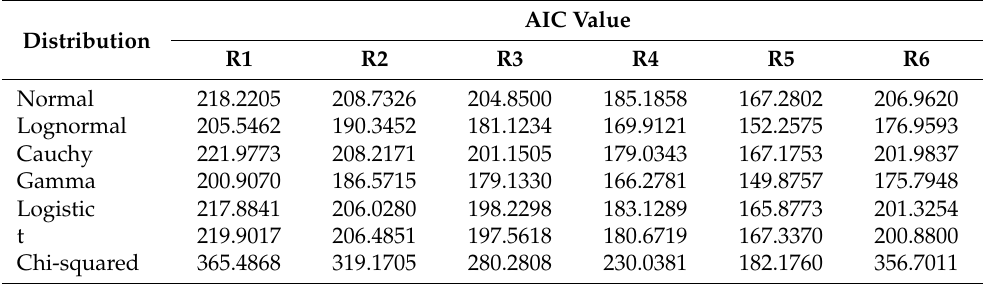
Table 6. AIC results to check the distributions of the positive daily rainfall